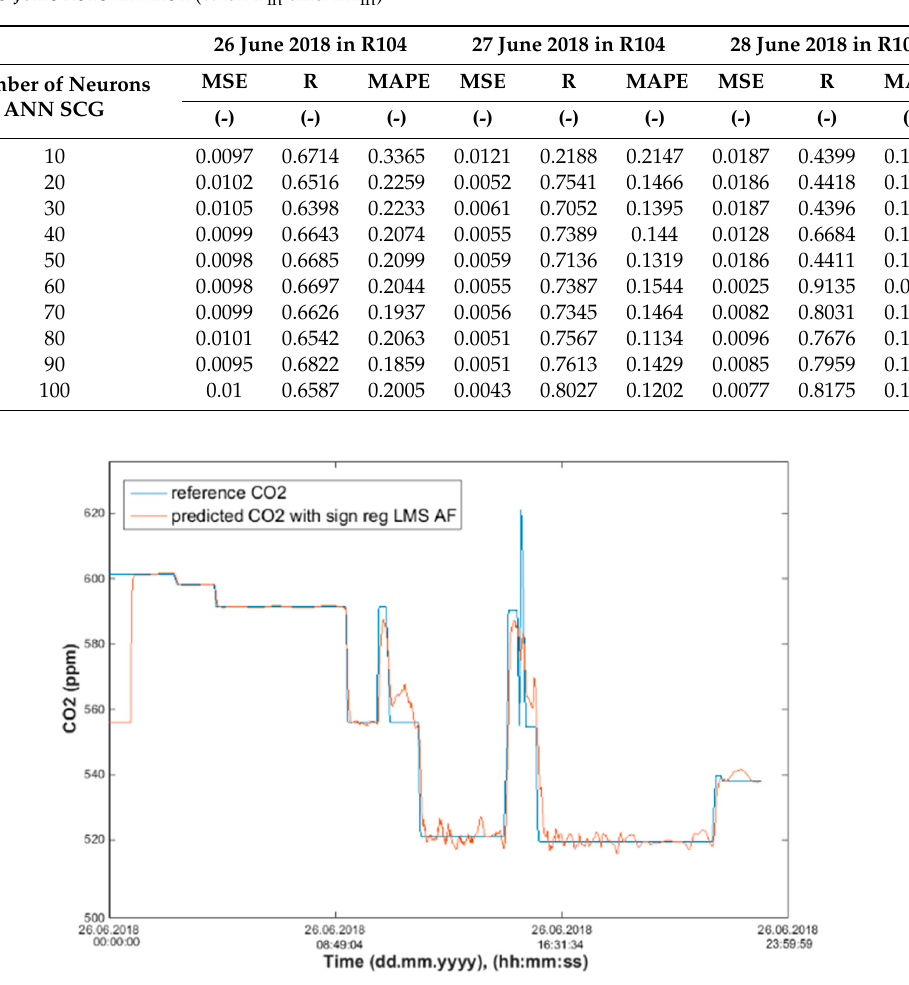
Figure 19. Comparison of the reference CO 2 concentration waveform and predicted CO 2 waveforms (SRLMS AF) from 26 June 2018 in R203 with an ANN with 100 neurons and SCG method trained with data from 25 June 2018 in R203.